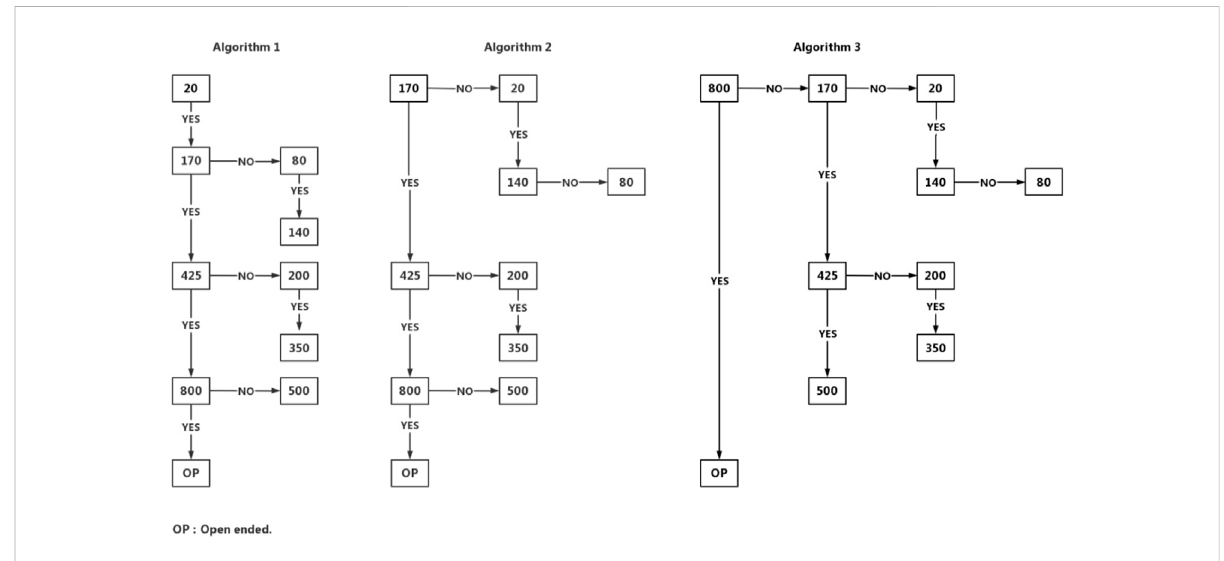
FIGURE 1 Iterative bidding game